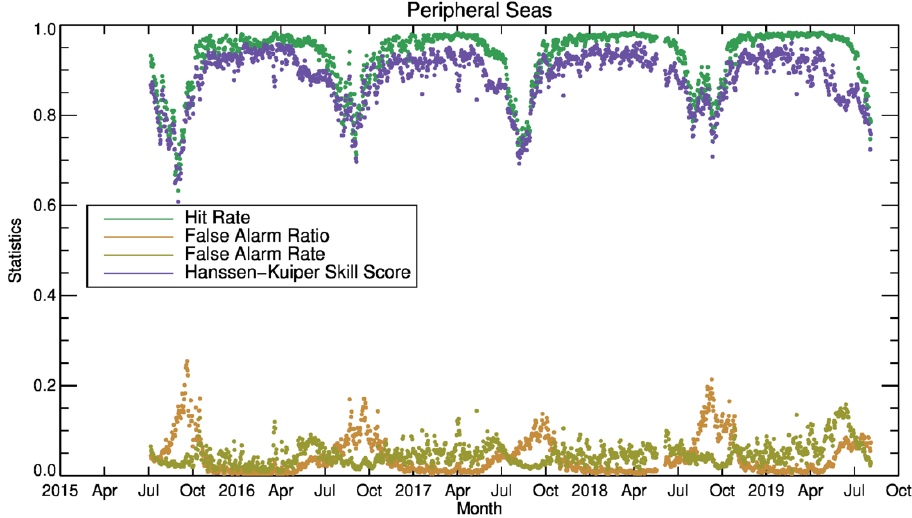
Figure 5. Same as Figure 4, except over the Peripheral Seas of the Arctic Ocean, including the Beaufort, Chukchi, East Siberian, Laptev, and Kara and Barents Seas.